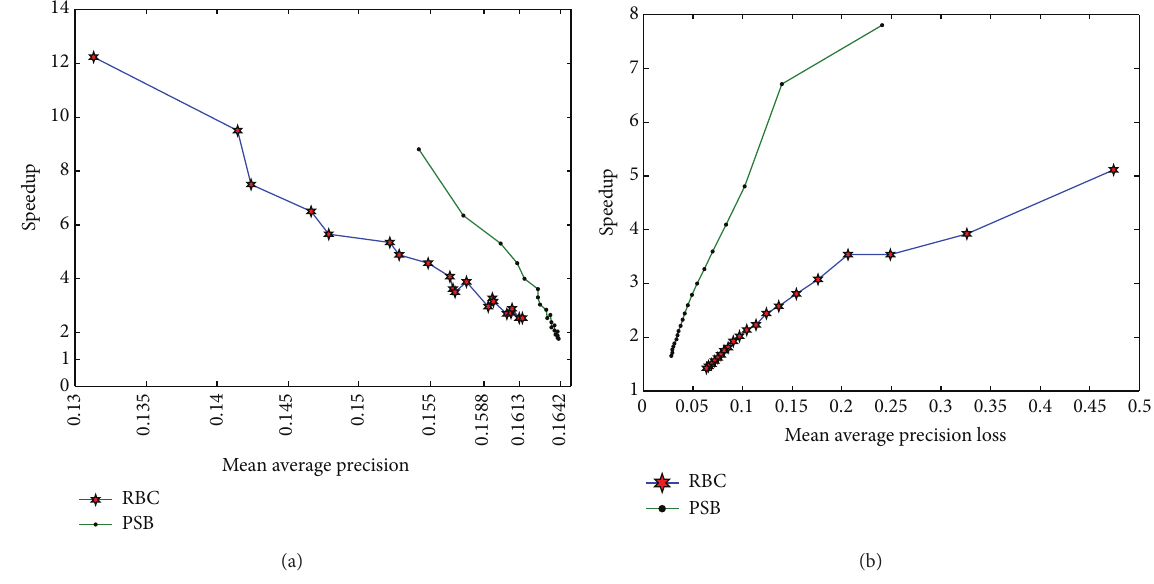
Figure 9: Comparisons with the state-of-the-art approach RBC. (a) Comparison on Corel 10K. (b) Comparison on GIST 1M.